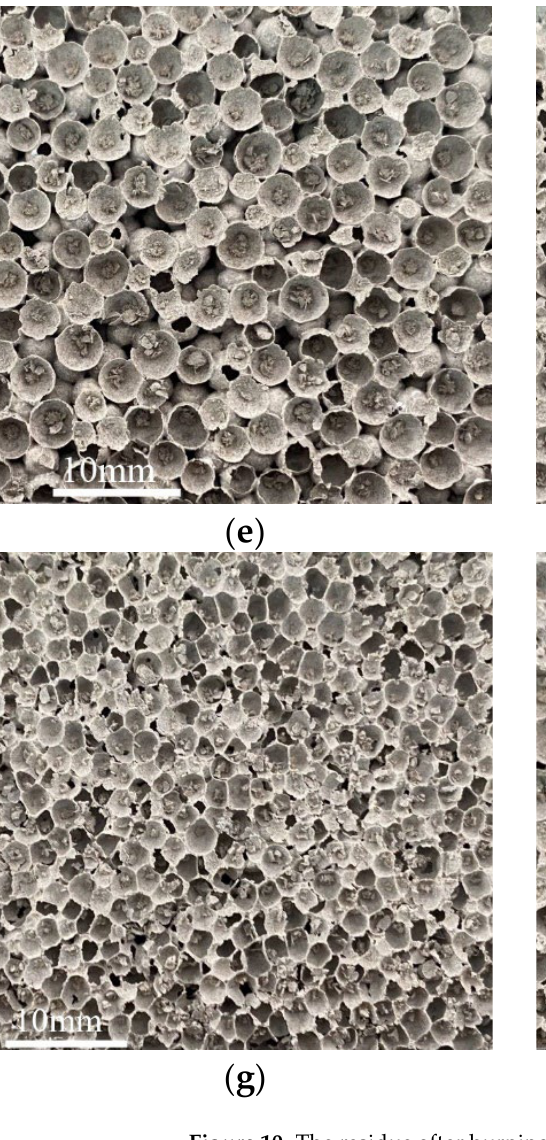
Figure 10. The residue after burning test: ( a ) specimens under test, ( b ) control, ( c ) LP, ( d ) SP, ( e ) CE, ( f ) LC, ( g ) HC, and ( h ) SS.